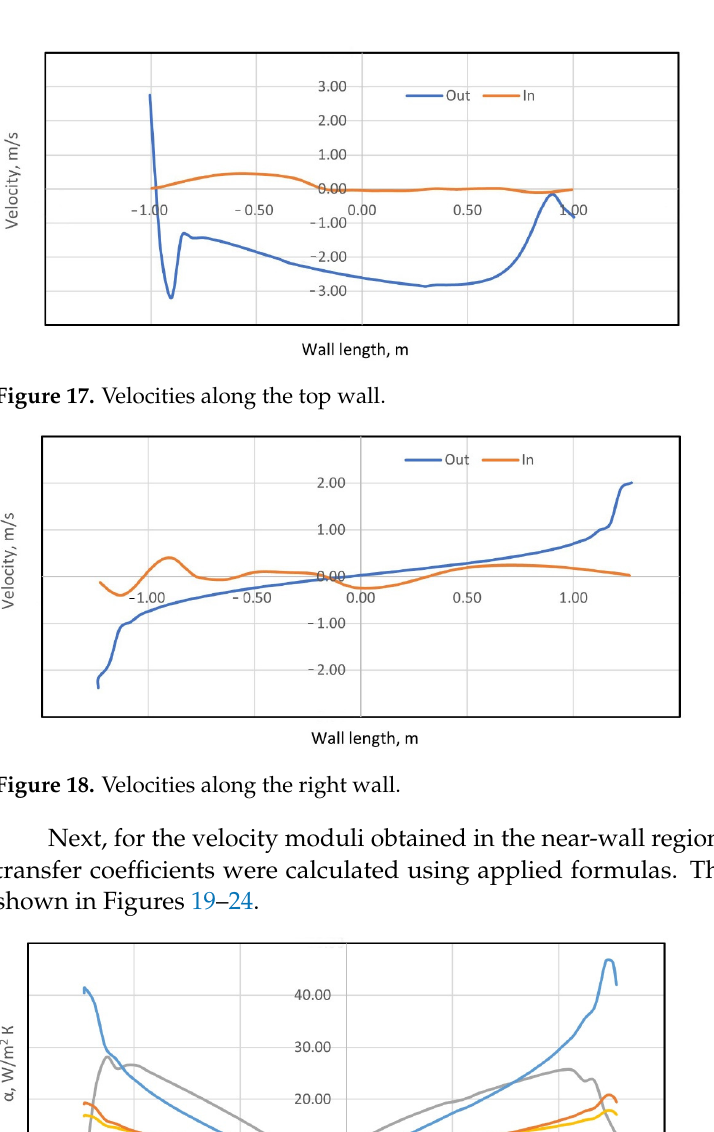
Figure 16. Velocities along the left wall.